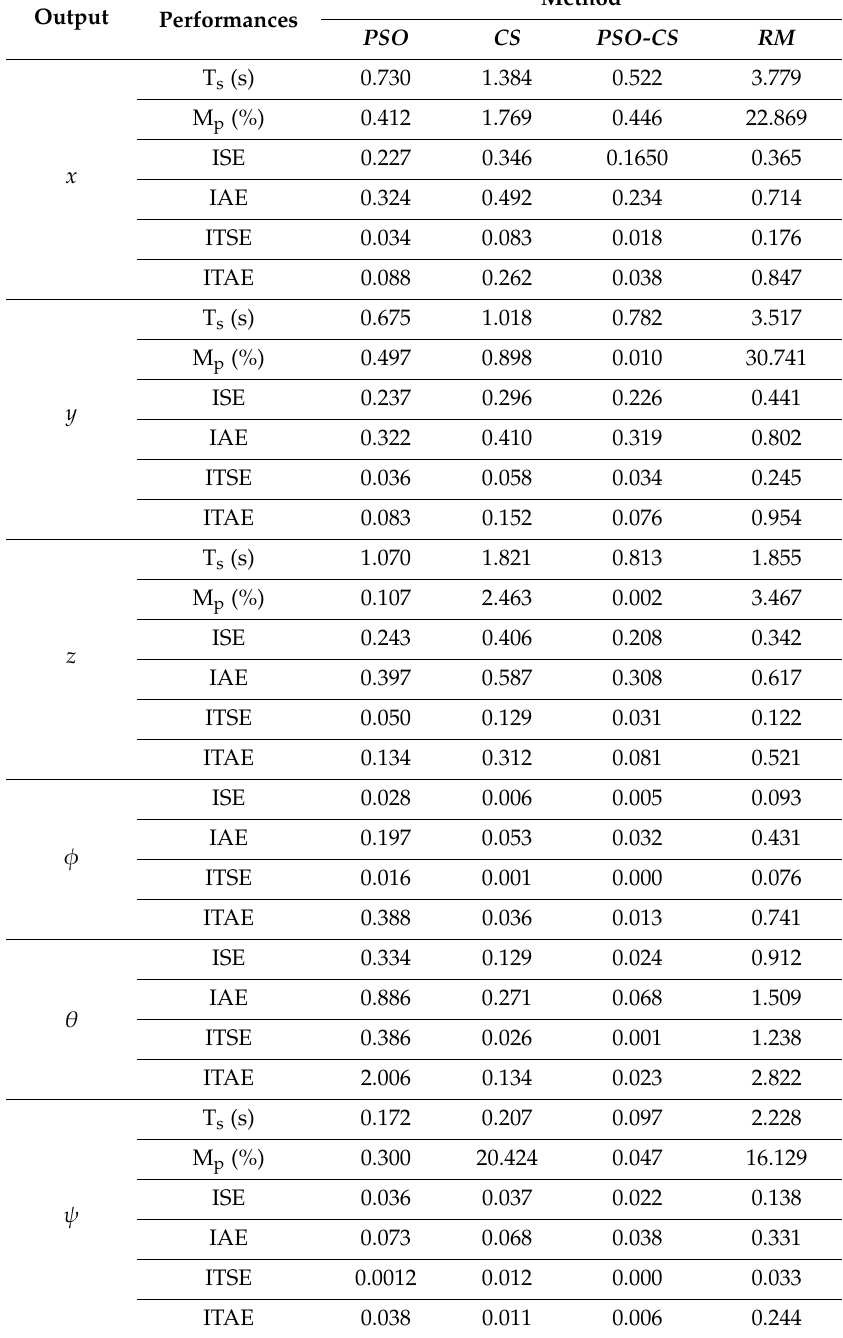
Table 4. Performances obtained with Particle Swarm Optimization (PSO), Cuckoo Search (CS), Particle Swarm Optimization-Cuckoo Search (PSO-CS), and Reference Model (RM) for the